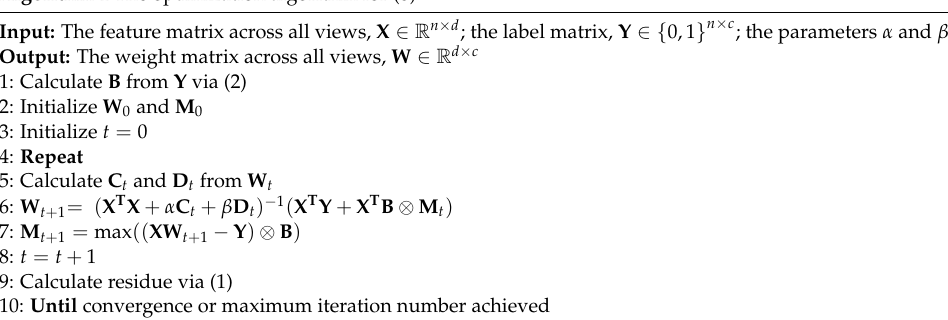
Algorithm 1 The optimization algorithm for (8)